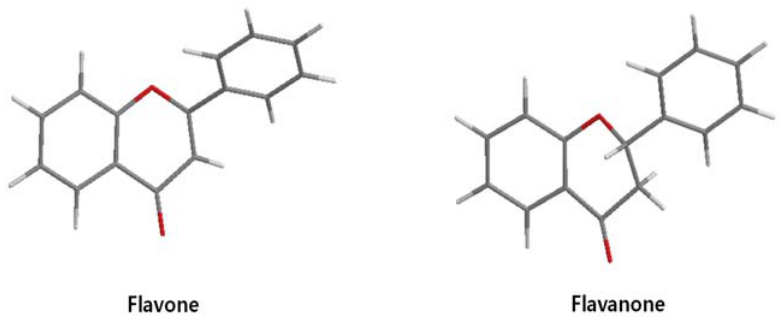
Figure 2. Flavone and flavanone.